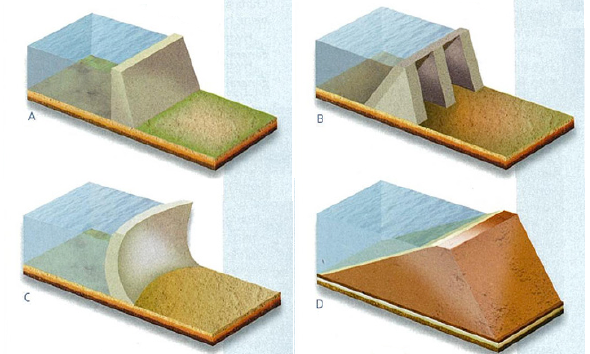
Figure 1. A – Gravity dam; B – Buttress dam; C – Arch dam; D – Embankment dam (adapted from